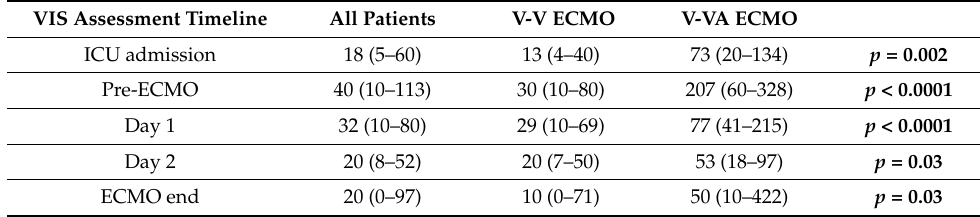
Figure A1. Clinical workflow on patients with respiratory failure. ECMO: Extracorporeal Membrane Oxygenation; V-V: Veno-Venous; V-VA: Veno-VenoArterial; MAP: mean arterial pressure; RV: right ventricular; LV: left ventricular; i.v.: intravenous. Table A1. VIS assessment at various time points.